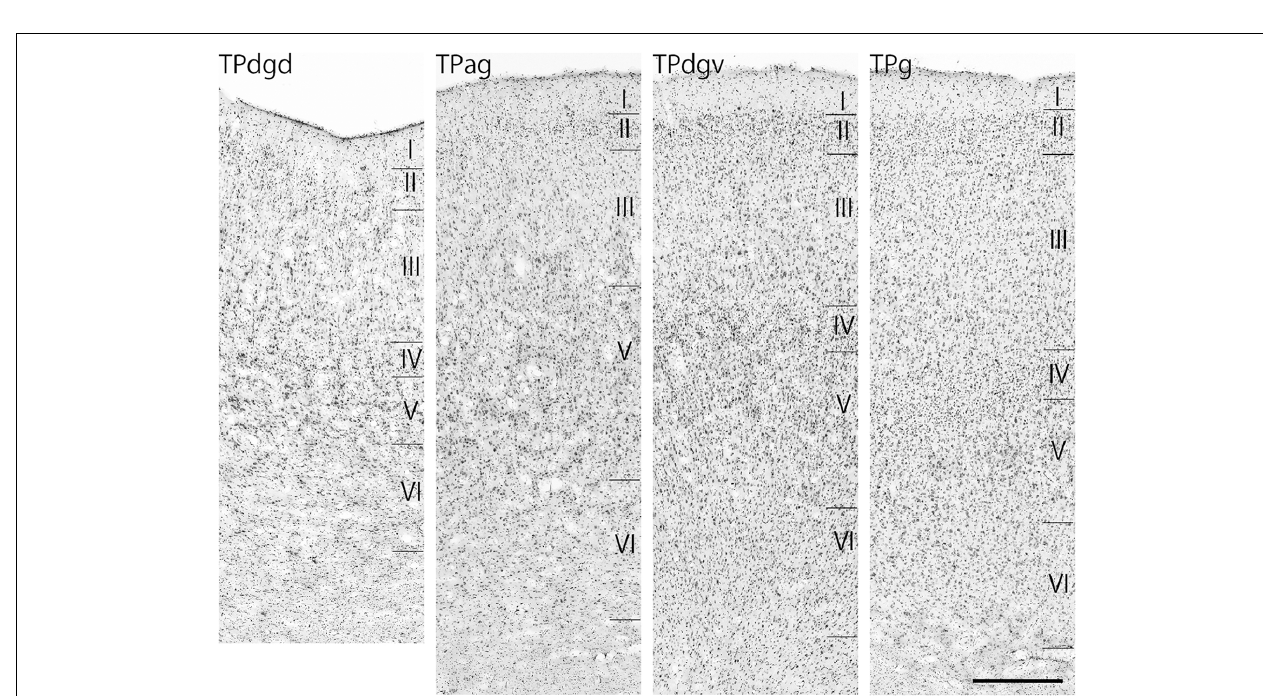
FIGURE 4 | Nissl-stained sections of the four temporal pole (TP) regions. Scale bar: 500 µ m. TPdgd, dorsal dysgranular region of the TP; TPag, agranular region of the TP; TPdgv, ventral dysgranular region of the TP; TPg, granular region of the TP.